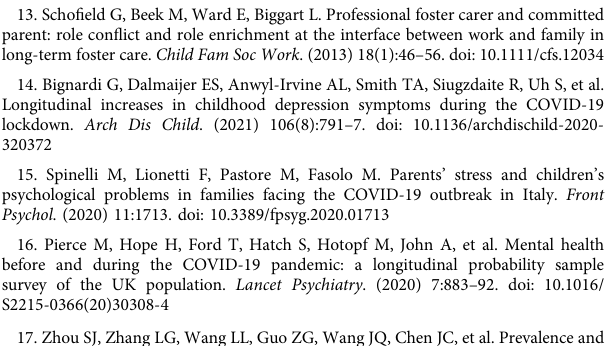
Figure 1 and Tables 1 – 3 . MD drafted the main manuscript